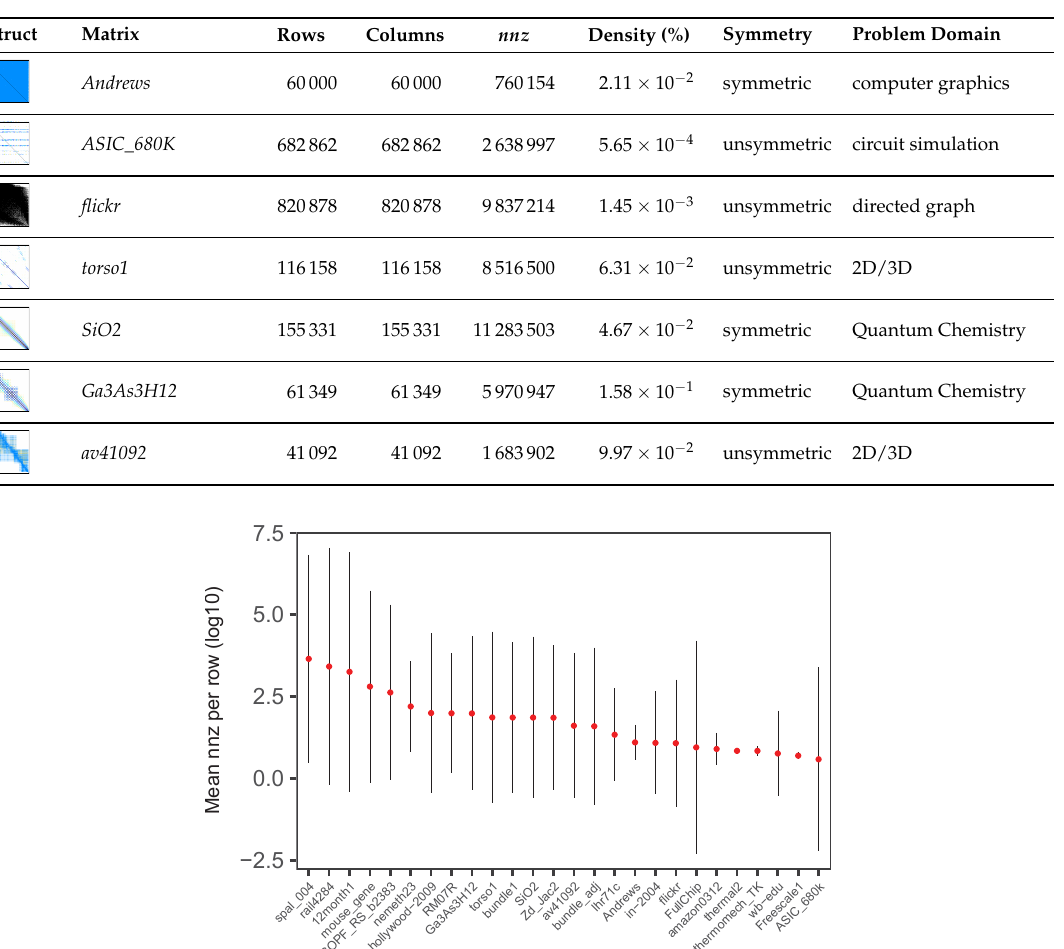
Figure 6. The normalized mean and the standard deviation of the matrices in the used Benchmark